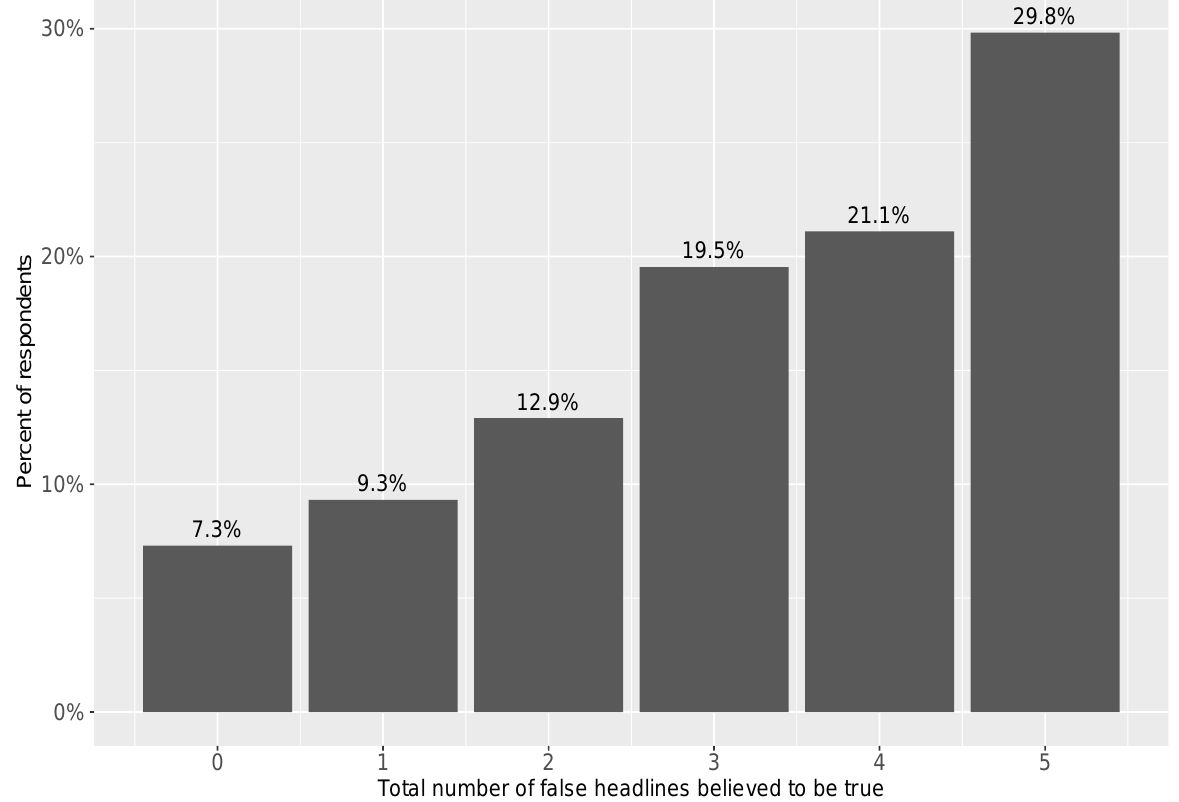
Figure A2. Percent of respondents who believed false headlines were